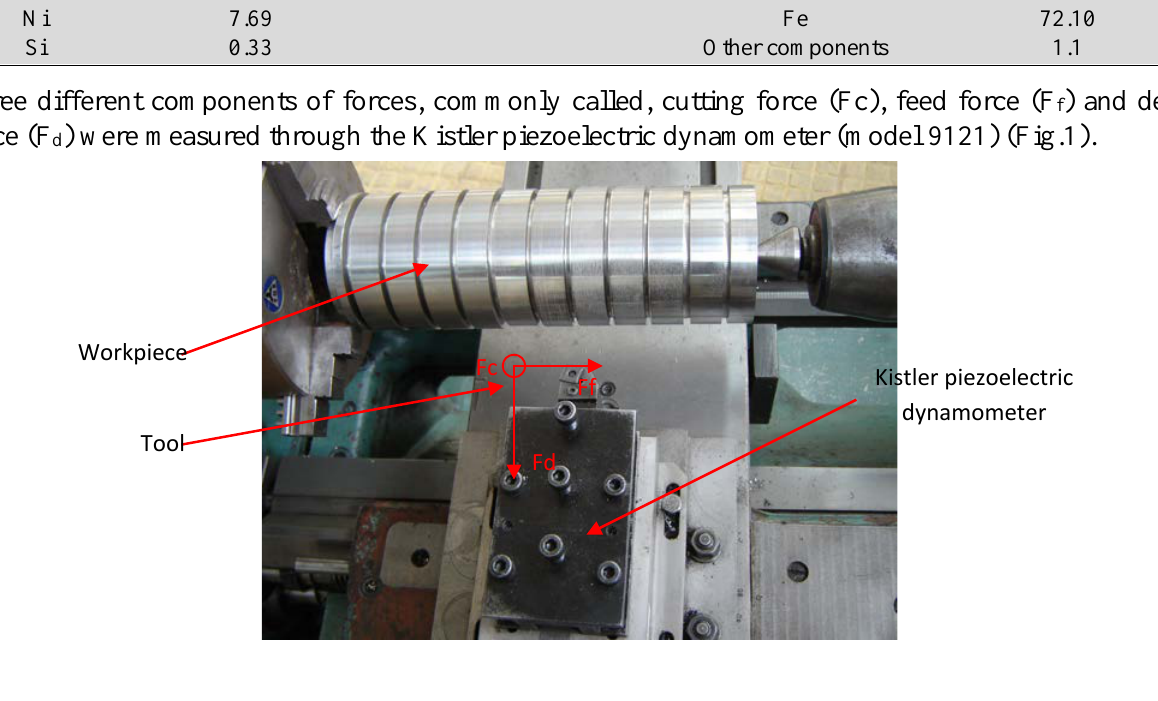
Fig.1. Experimental configuration for measuring cutting